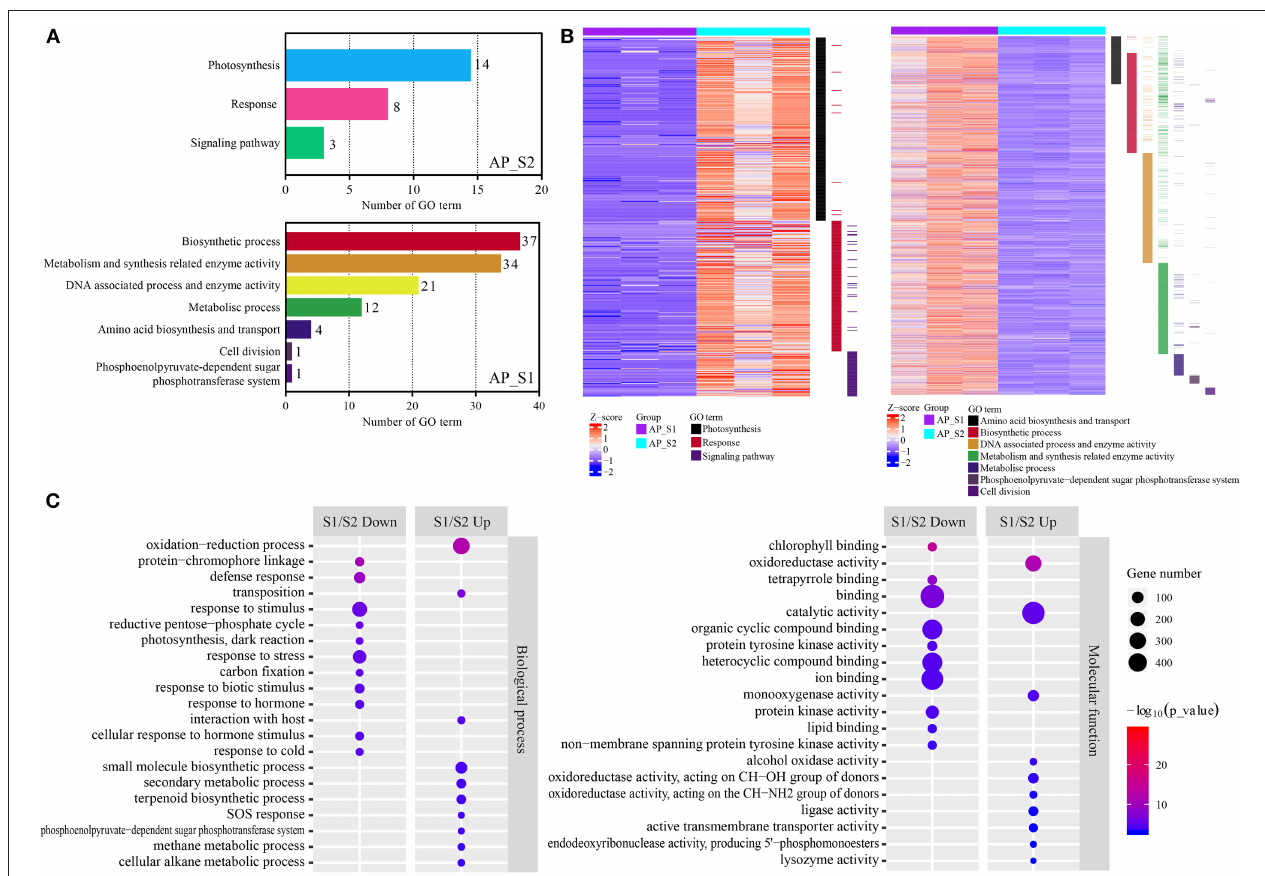
FIGURE 4 | The Gene Ontology (GO) analysis between the two different harvesting periods of A. polytricha . (A) The GO analysis by the gene set enrichment analysis (GSEA) of all the unigenes. (B) The unigenes expression level of “AP_S1” and “AP_S2” involved in those GO terms. (C) Biological process (left) and molecular function (right) by the GO analysis of the